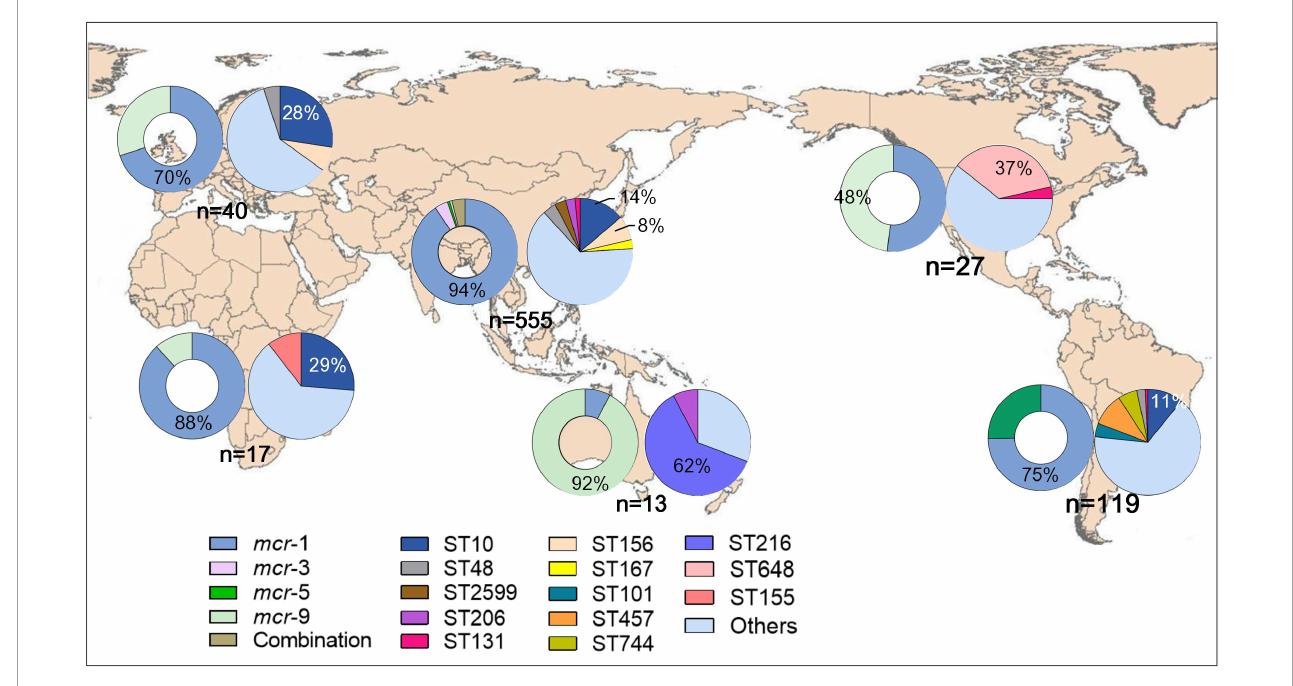
FIGURE2 Geographical distribution of mcr and STs of mcr-positive Escherichia coli worldwide. The hollow and solid pie charts of each continent represent the distribution of mcr and STs,